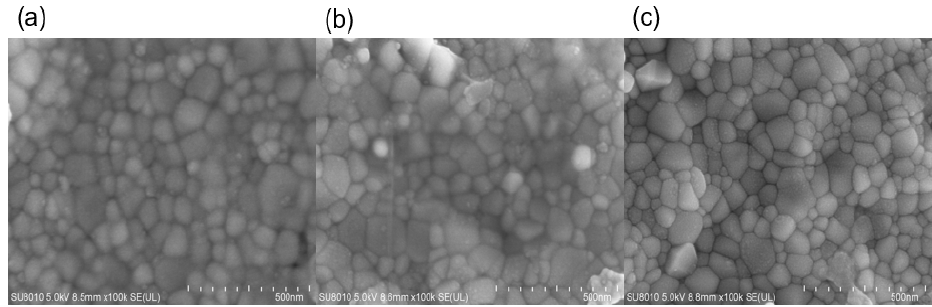
Figure 3. SEM images of ( a ) positive pole; ( b ) negative pole; ( c ) middle.